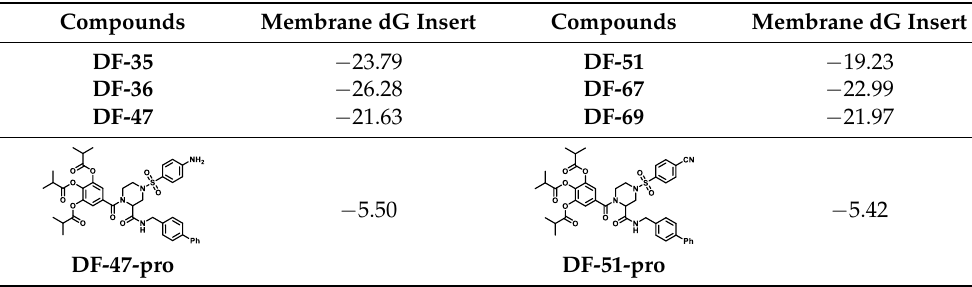
Table 4. Permeability prediction value of selected compounds.